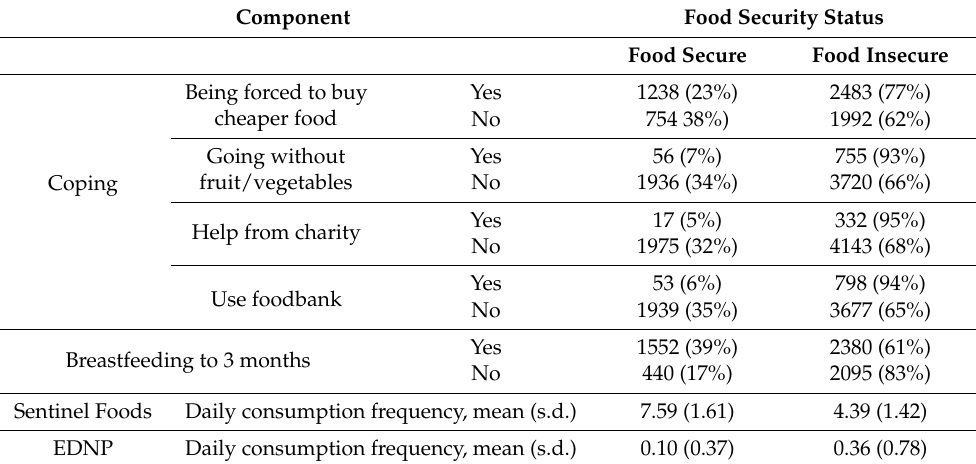
Table 5. Food security components by